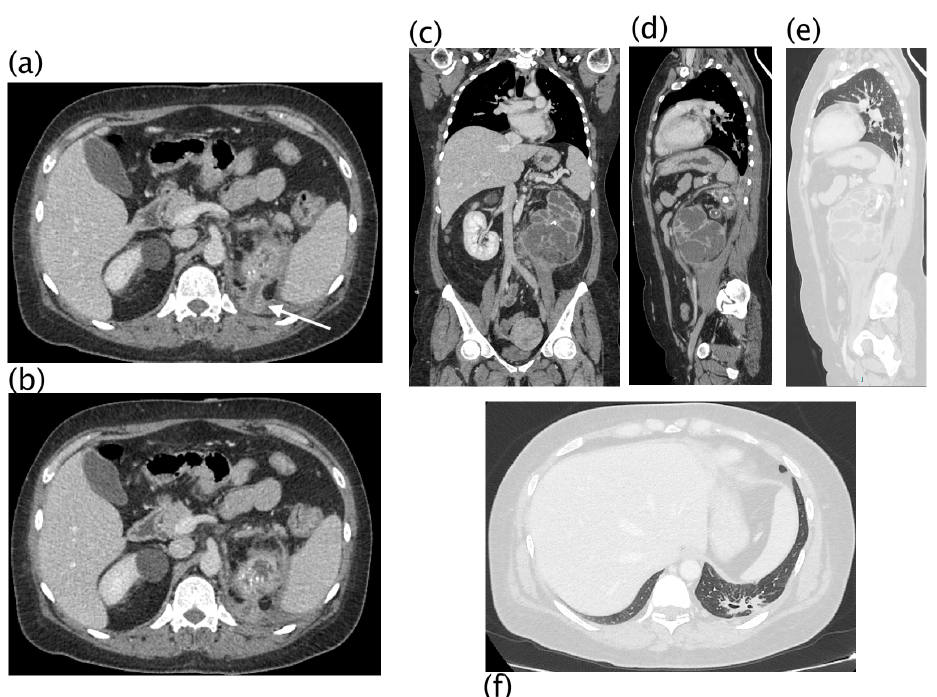
Figure 6. Xanthogranulomatous pyelonephritis Stage III—pararenal form CT with contrast agent: axial ( a , b , e ), coronal ( c ), and sagittal ( d ) MPR reconstructions with lung window ( e , f ). Patient admitted for persistent cough and left basal opacity on chest X-ray examination. On CT examination, morpho-structural alteration of the kidney with gross intraparenchymal collections alternating with dilated calyces is present. An upper polar fistulous via ( a , b ) is well evident (white arrow) that continues into the lung in direct continuity with a bronchus, more evident in sagittal reconstructions. Recognition of the fi stulous via on CT was visible in 22.22% of patients.